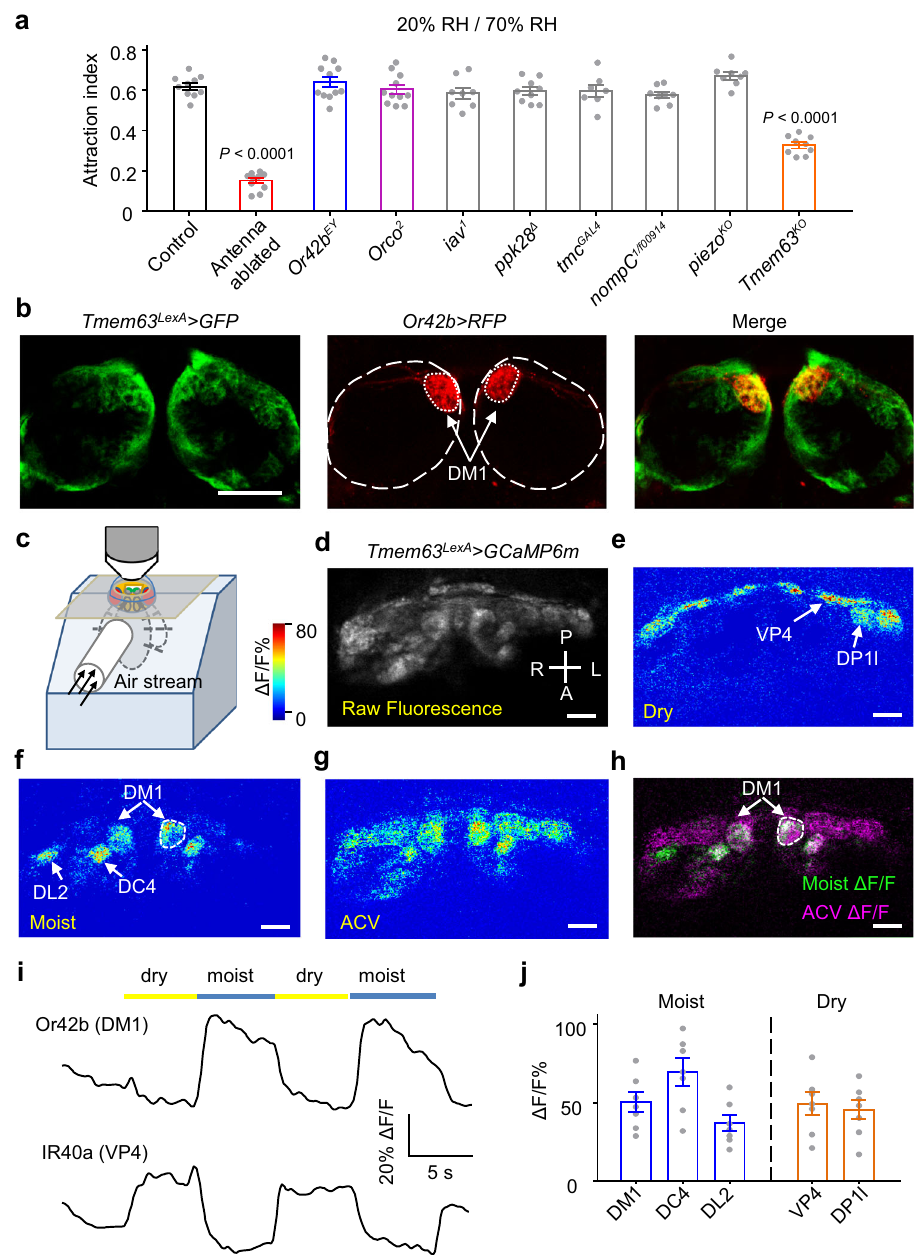
Fig. 3 Identi fi cation of humidity sensitive OSNs by using a knock-in driver of Tmem63 . a Plateau attraction indexes for several olfactory receptor and mechanosensitive channel mutants tested in the 20 – 70% RH condition. n = 10, 10, 11, 11, 8, 9, 7, 8, 8, 9 assays. One-way ANOVA followed by Dunnett ’ s test for multiple comparison with the control group. b Tmem63 > GFP -labeled and Or42b > RFP -labeled axons project to overlapping regions of the antennal lobe. White dashed lines indicate the border of DM1 glomerulus and antennal lobe. Scale bar, 50 μ m. Genotype: UAS - mCD8-RFP,LexAop2-mCD8-GFP ; Tmem63 LexA / + ; Or42b-Gal4 / + . Representative images of three biological replicates. c Schematic illustration of in vivo calcium imaging in the antennal lobe. d Raw fl uorescence image of Tmem63 -expressing axons (in a Tmem63 LexA / + ; LexAop2-GCaMP6m / + animal) innervating the antennal lobe. Scale bar, 20 μ m. e – g Pseudo color images showing GCaMP6m responses ( Δ F/F 0 ) of Tmem63 -expressing neurons to humidity stimulations or 1% apple cider vinegar (ACV). Scale bar, 20 μ m. h Δ F/F 0 response to moist air (green) overlaid on Δ F/F 0 response to vinegar (magenta). Scale bar, 20 μ m. d – h Representative images from over three independent replicated experiments. i Representative traces for moisture-activated response of DM1 glomerulus (upper) and dry air-activated response of VP4 glomerulus (lower) in different humidity changing cycles. j Peak Δ F/F 0 in response to humidity changes. n = 7 fl ies for each group. Data are mean ± SEM. Source data are provided as a Source Data fi